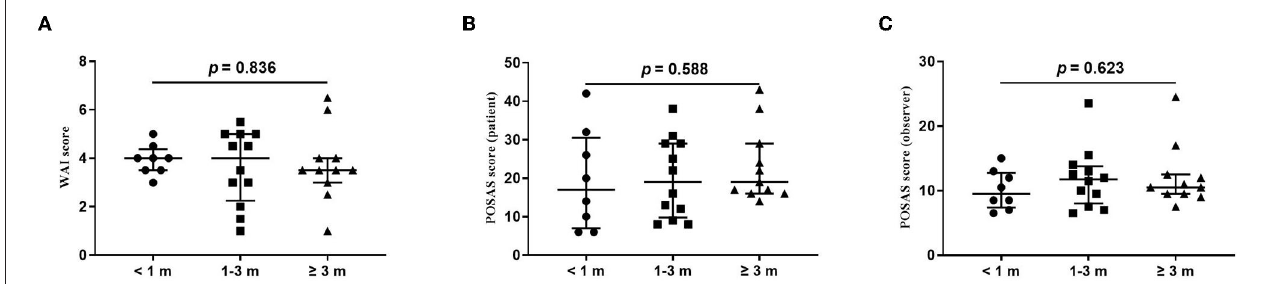
FIGURE 2 | Comparison of total score of wound assessment inventory (WAI) and patient and observer scar assessment scale (POSAS) between patients undergoing the surgical suture with different vaccination intervals. (A) WAI at 7 d follow-up; (B) POSAS patient scale at three-month follow-up; (C) . POSAS observer scale at three-month follow-up; vaccination interval was defined as an interval between the time of the last dose of COVID-19 vaccination and the time of surgical sutures. The numbers of patients in groups of < 1 month, 1–3 months, and ≥ 3 months were 8, 11, and 12,